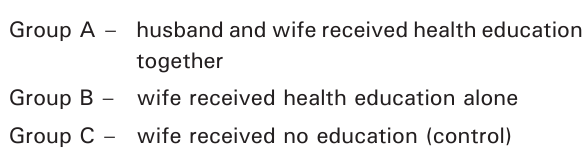
figure 1. cOnsORt diagram of study participants and their study participation (bQ = baseline questionnaire, PPQ = postpartum questionnaire, PPV = postpartum checkup